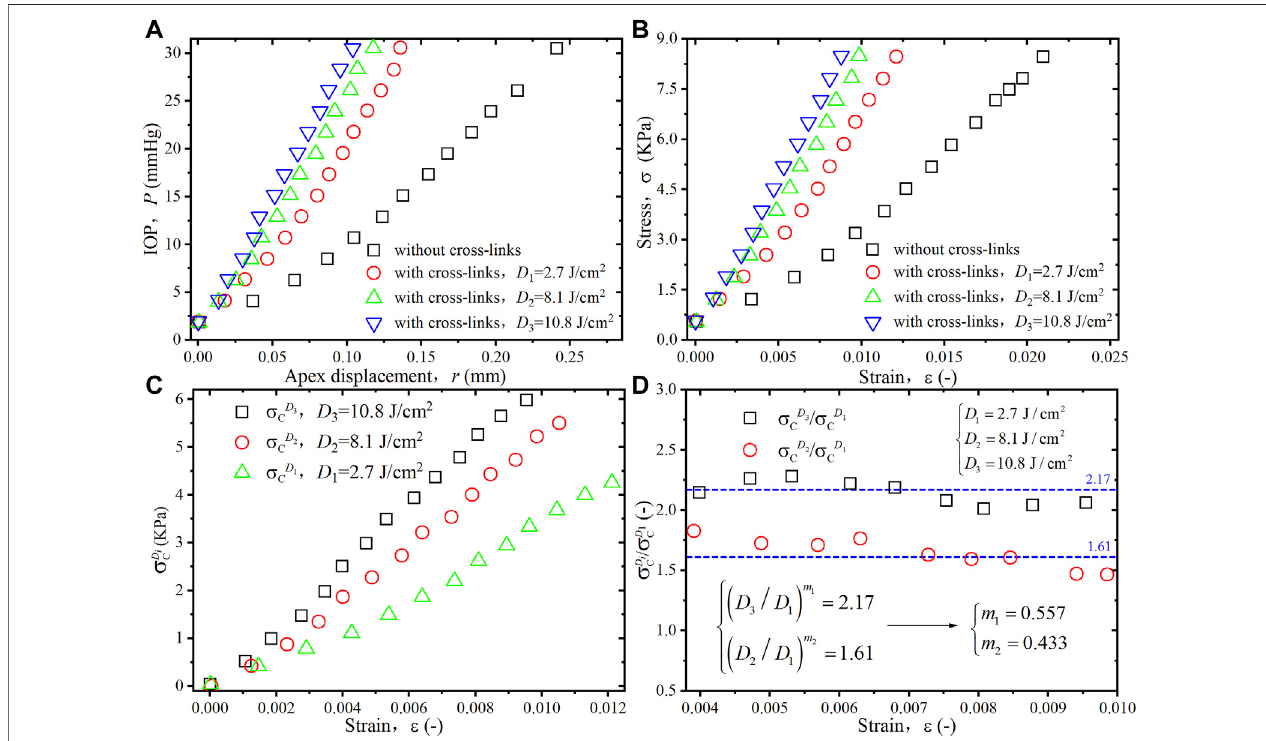
FIGURE 4 | (A) Experimental data for the IOP-apex displacement ( P - r ) relationships of porcine cornea at different irradiation doses (Boschetti et al., 2021). (B) Equivalentstress-strain( σ − ε )relationsatvariousirradiationdosesfollowingtheconversionformulaof(Andersonetal.,2004). (C) Evolutionof σ D i C ( i (cid:1) 1 , 2 , 3)withrespect to the strain ε at three irradiation doses, i.e., D 1 (cid:1) 2 . 7J/cm 2 , D 2 (cid:1) 8 . 10J/cm 2 and D 3 (cid:1) 10 . 8J/cm 2 . (D) Variation of σ D 3 C / σ D 1 C and σ D 2 C / σ D 1 C as a function of ε .